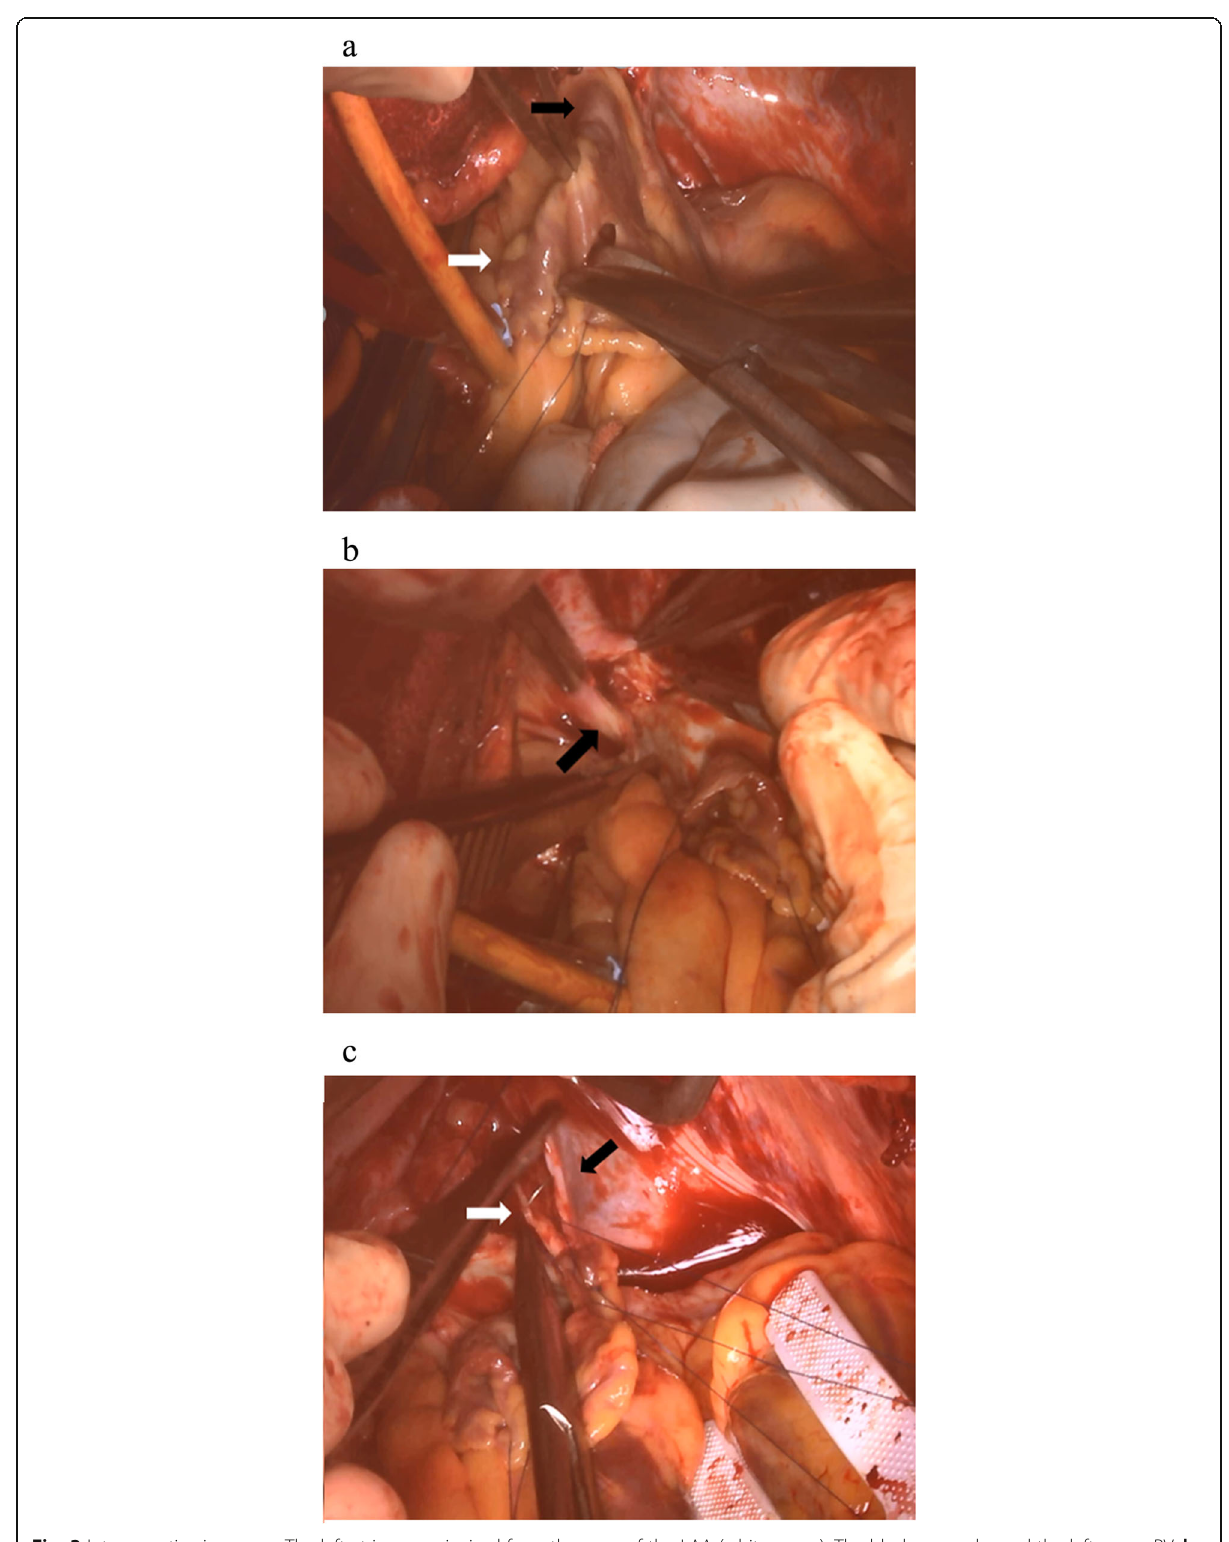
Fig. 3 Intraoperative images. a The left atrium was incised from the apex of the LAA (white arrow). The black arrow showed the left upper PV. b The ostium of the left upper PV was completely occluded with fibrous scaring (black arrow). c The anastomosis line switched from the left atrium (white arrow) to the pericardium (black